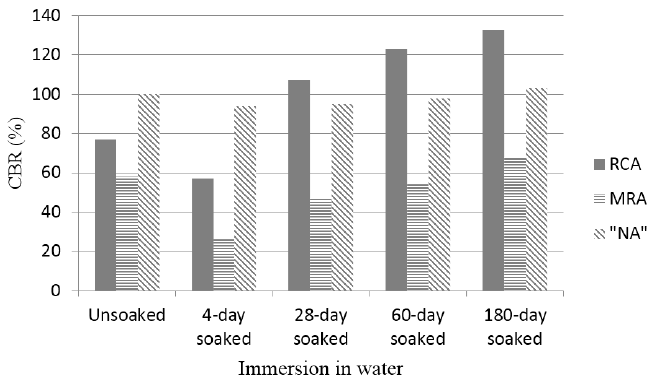
Figure 3. CBR values (unsoaked, 4 ‐ day soaked, 28 ‐ day soaked, 60 ‐ day soaked and 180 ‐ day soaked).